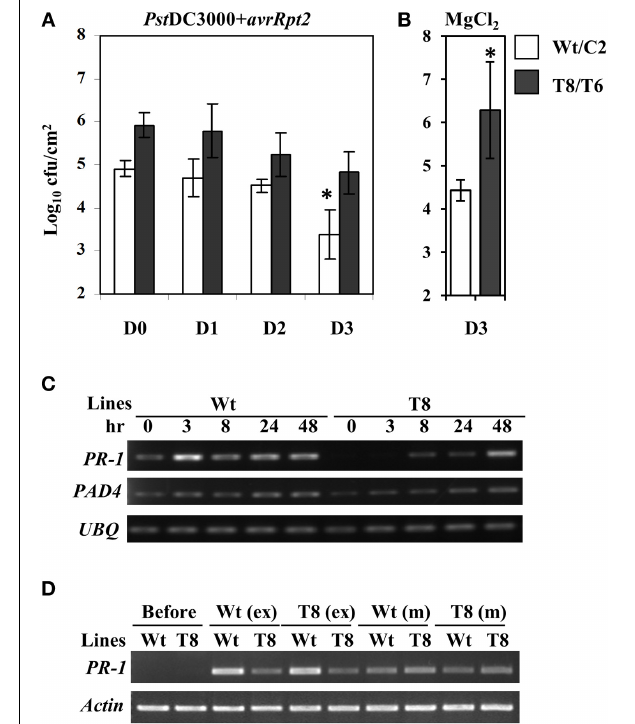
FIGURE 5 | The SAR response is delayed in the InsP 5-ptase plants. The SAR assay was carried out using wild type (Wt), vector control (C2) and two independent InsP 5-ptase lines (T6 and T8). Plants were either first inoculated with Pst DC3000 + avrRpt2 (OD 600 = 0 . 001, 7 × 10 5 cfu/ml) (A) , or 10mM MgCl 2 mock solution (B) , then sprayed with Pst DC3000 (OD 600 = 0 . 004, 2 × 10 6 cfu/ml) at day 0, 1, 2, or 3. Systemic leaves were harvested and the bacterial growth was quantified at day 4 post spray. Data is the average of three experiments ± SD. Each experiment has three plants per line. Results from Wt and C2 (Wt/C2), and T6 and T8 (T8/T6) were pooled for analysis. ∗ P < 0 . 05 (C) Systemic leaves were also harvested before (0) and after initial inoculation at 3, 8, 24, and 48h for RT-PCR carried out with gene-specific primers for PR-1 , PAD4 , and UBQ10 . (D) For the exudate experiment, only Wt and T8 and their reciprocal treatments are shown. Leaves were harvested before or at 48h post exudate (ex) or mock (m) infiltration for RT-PCR carried out with gene-specific primers for PR-1 and Actin